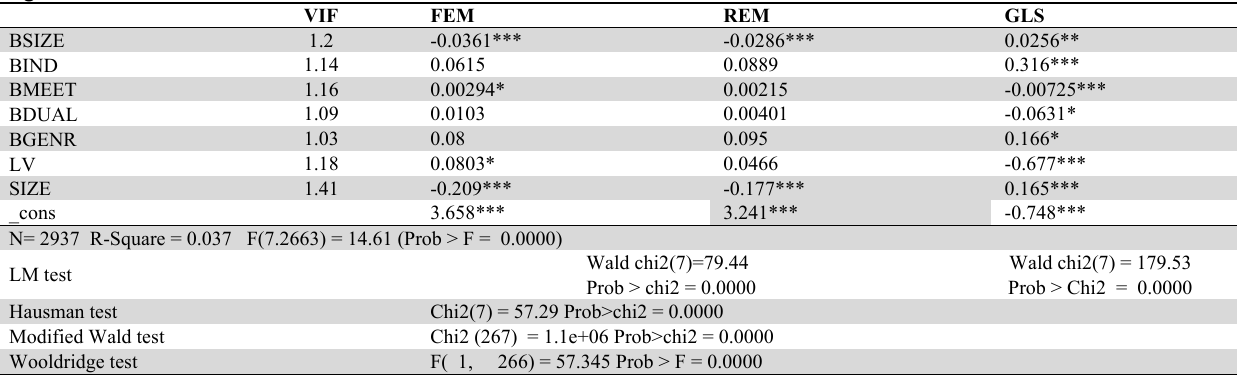
Regression results of model